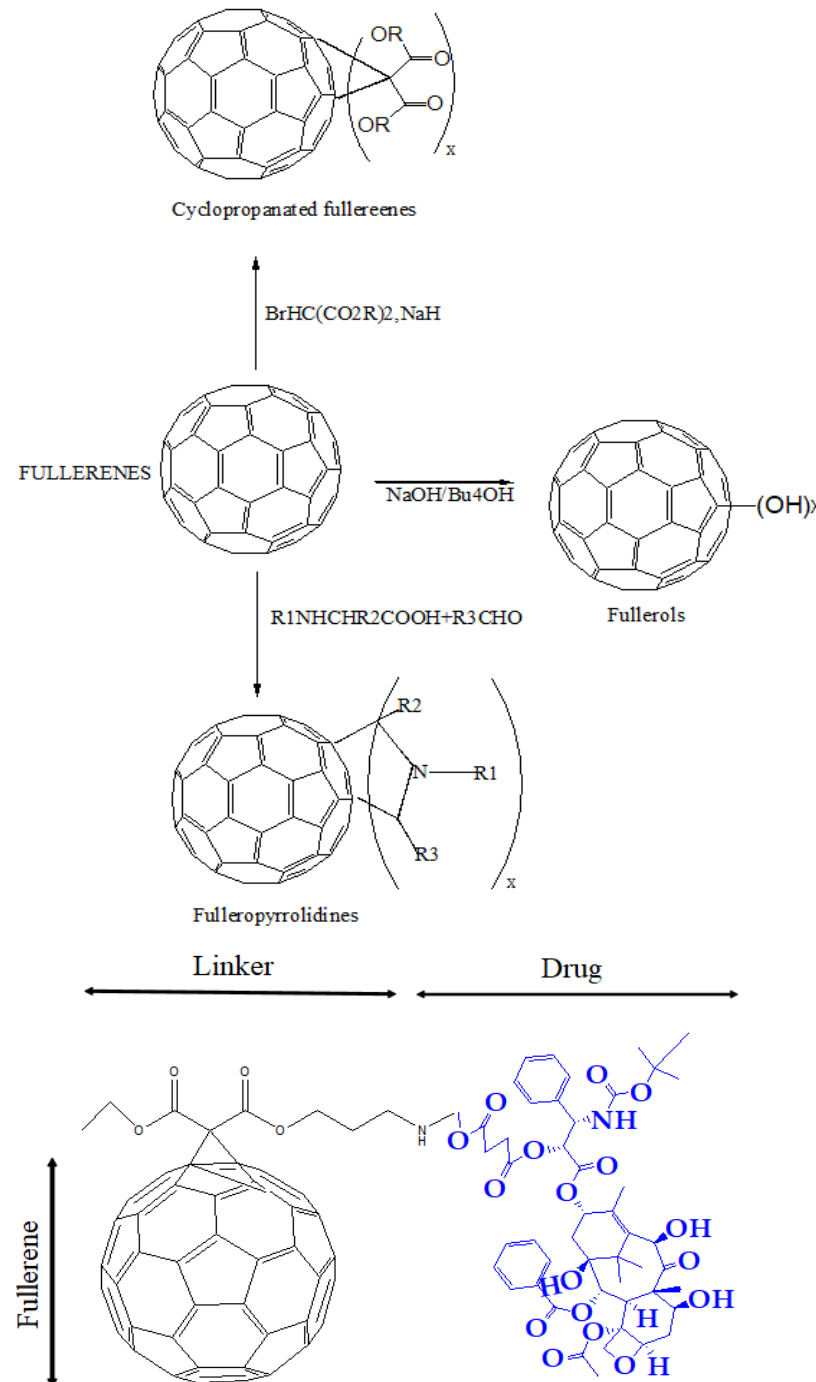
Figure 2. The functionalization of fullerenes and their conjugation with a drug using a linker.